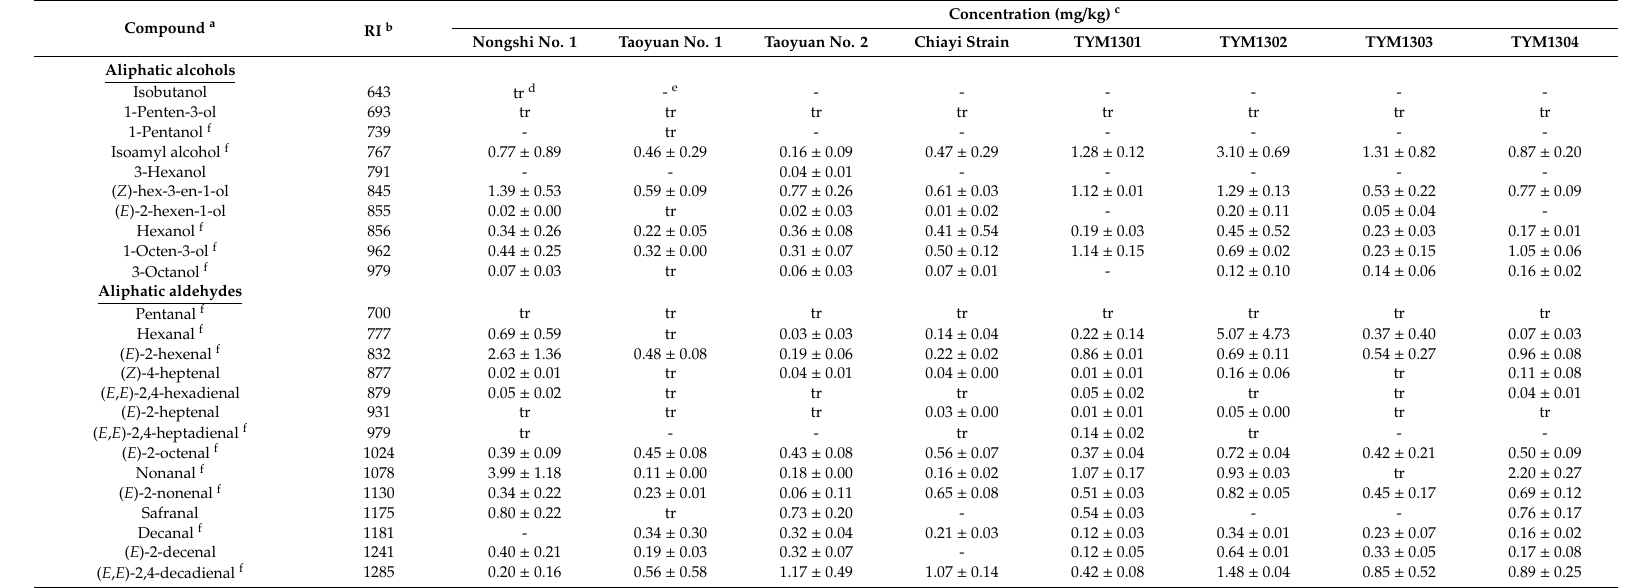
Table 4. Comparisons of volatile compounds from eight varieties of Hsian-tsao extracted using